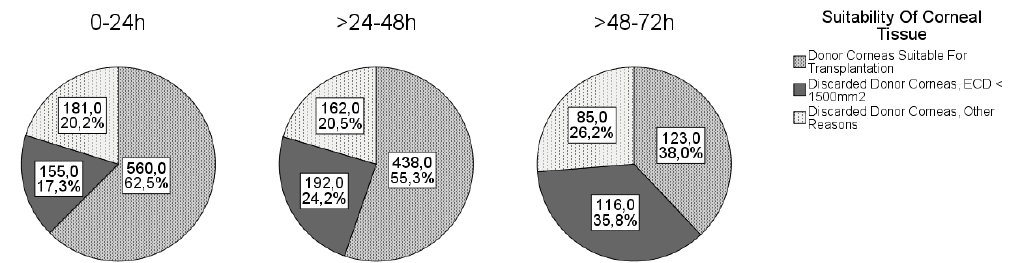
Figure 1. Corneal suitability in different death-to-explantation intervals.